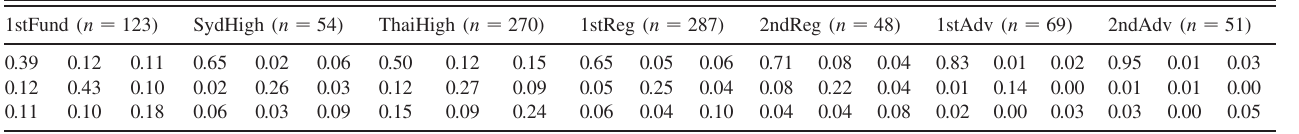
TABLE VIII. Average class density matrices for questions 6–8 on